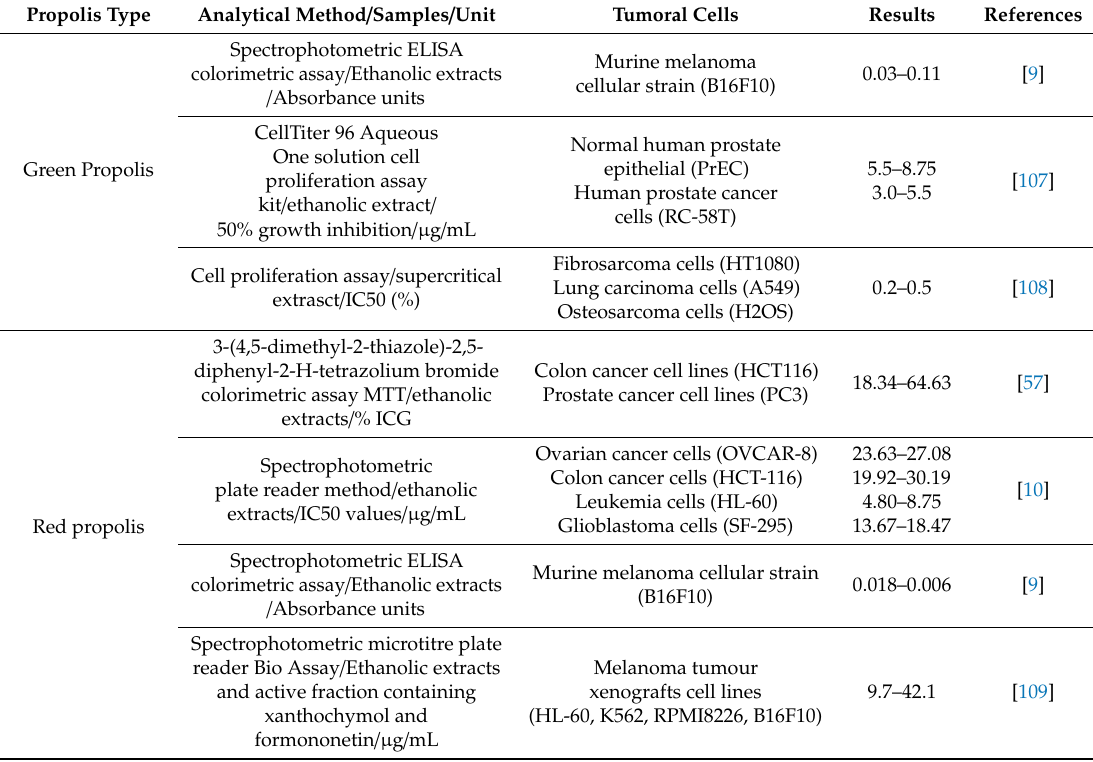
Table 3. Antitumor and anti-proliferative of red and green Brazilian